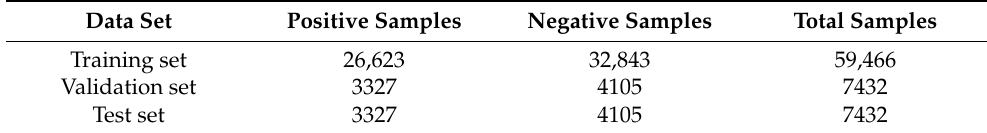
Table 5. Distribution of the dataset.